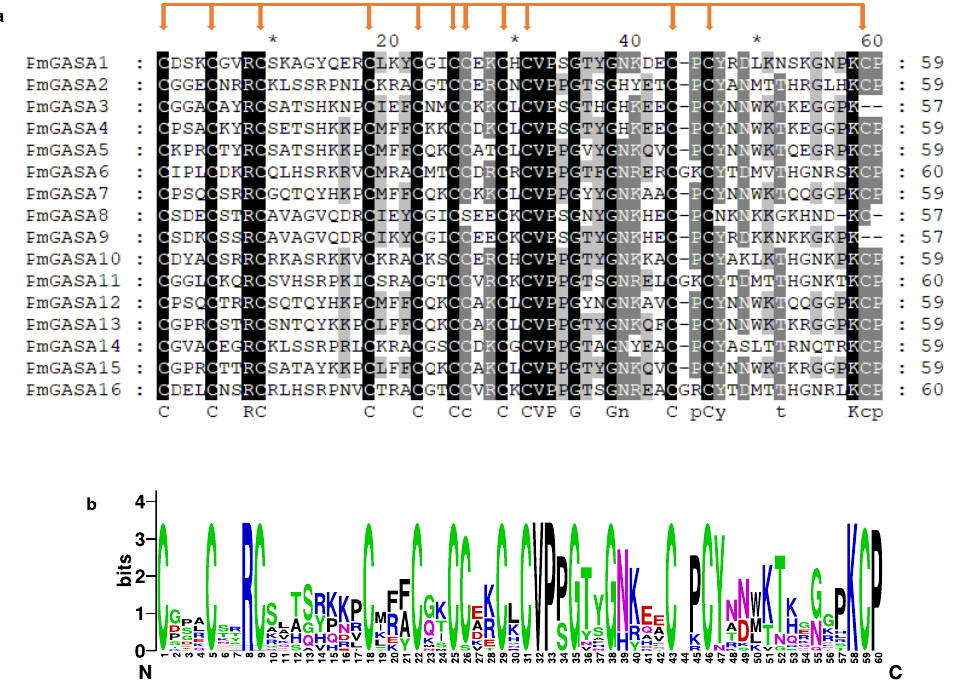
Figure 2. Amino acid alignment of GASA domain from PmGASA proteins. ( a ) Multiple alignment of the PmGASA protein sequences within the GASA domain. The alignment was visualized in GeneDoc, with grey shading indicating the amino acid identity. The featured cysteines within the GASA domain are highlighted with red arrows. The 10 th , 30 th , 50 th amino acid residues were labeled with *. ( b ) Sequence logo analysis of the conserved GASA domains performed with WebLogo